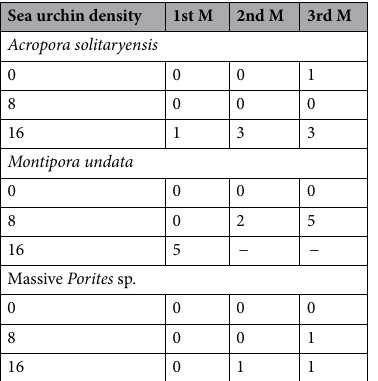
Massive Porites